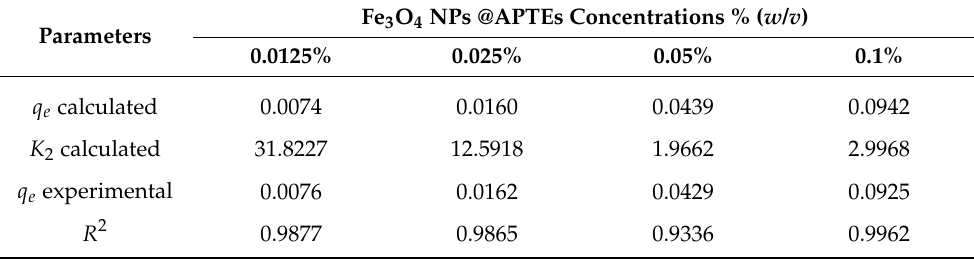
Table 3. Experimental and PSO parameters for Fe 3 O 4 NPs @APTES at four different substrate